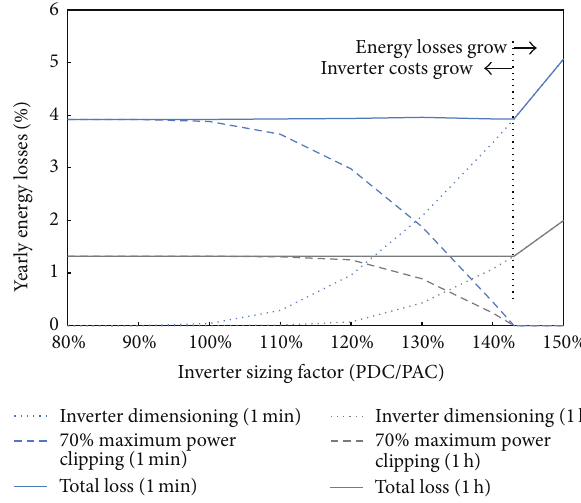
Figure 1: Power output of a 1kWp PV system at HTW Berlin, Germany, on April 01, 2012, measured one-minute values (grey) and hourly averaged values (blue). The yield losses due to maximum power clipping (output power is cut above 700 W) are calculated. one-minute power output values, an energy yield loss of 10%